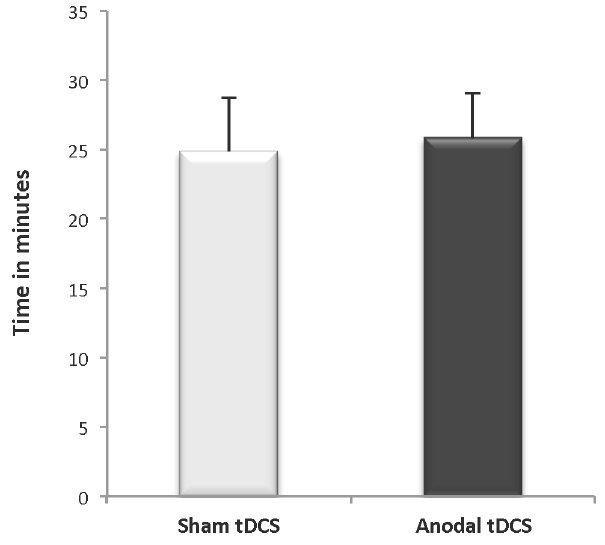
Figure 4. Time to Task Failure for a sustained contraction performed with anodal tDCS delivered for 20-mins and with a sham condition (n=18). Mean ( 6 SE) time to task failure (TTF) for sustained, submaximal elbow flexor contraction did not differ between stimulation conditions (Sham TTF 25.85 6 13.78 min; Anodal TTF 24.85 6 16.77 min; p